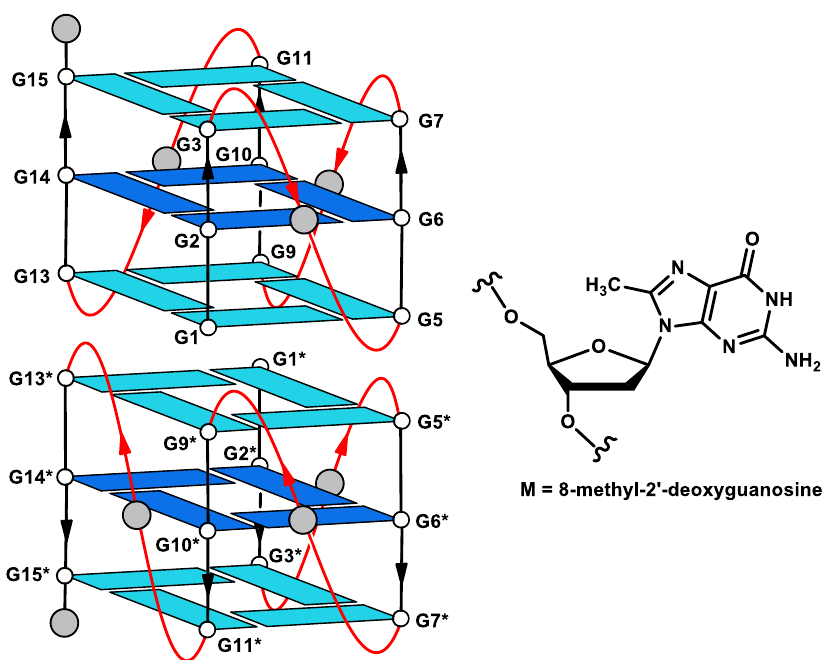
Figure 1. Schematic representation of the parallel-stranded G4 dimer structure of Table 1. (INT-nat). Residues in dark blue have been singly replaced by M residues in the T30923 variants (Table 1). Thymidines are indicated by grey circles. Table 1. Sequence, melting temperature (T m ) and effect of the modified oligodeoxynucleosides (ODNs) on the HIV-1 integrase activity. Oligonucleotide